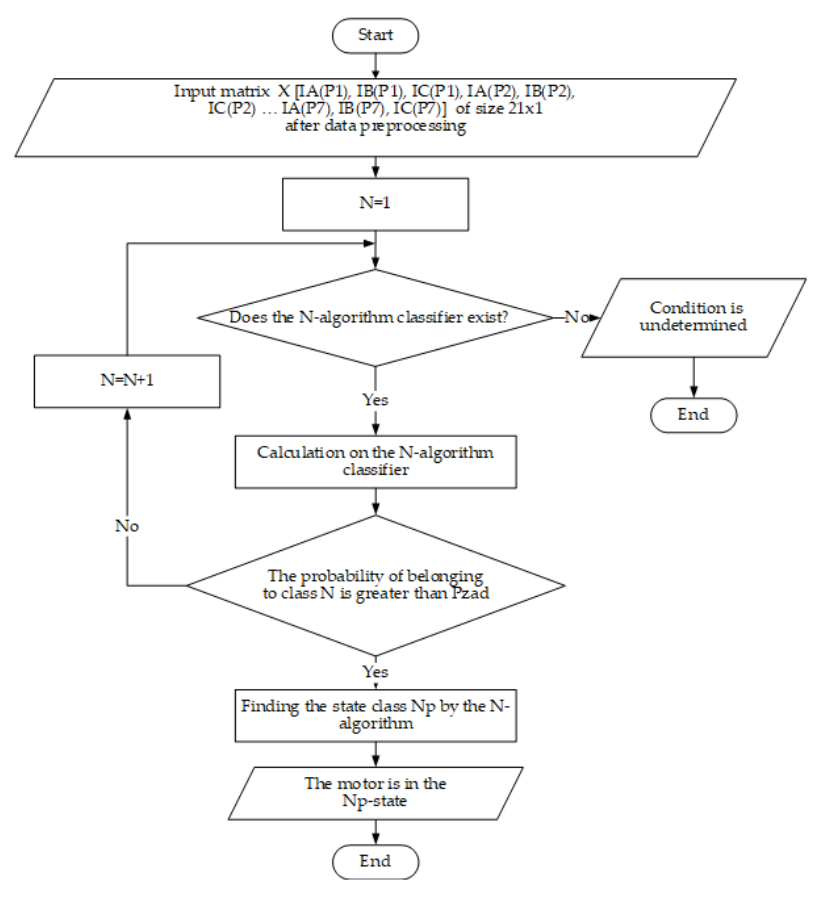
Figure 3. Ensemble Learning Algorithms.